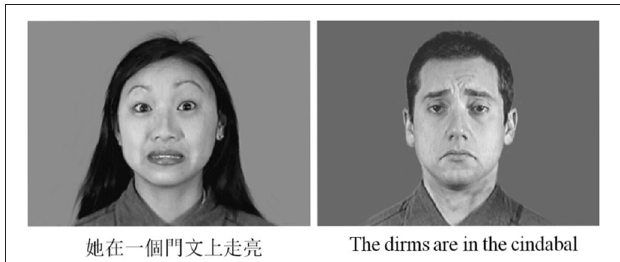
FIGURE 1 | Examples of facial and vocal stimuli . Left, example of Chinese fearful face and Chinese pseudo-sentence. Right, example of Caucasian sad face and English